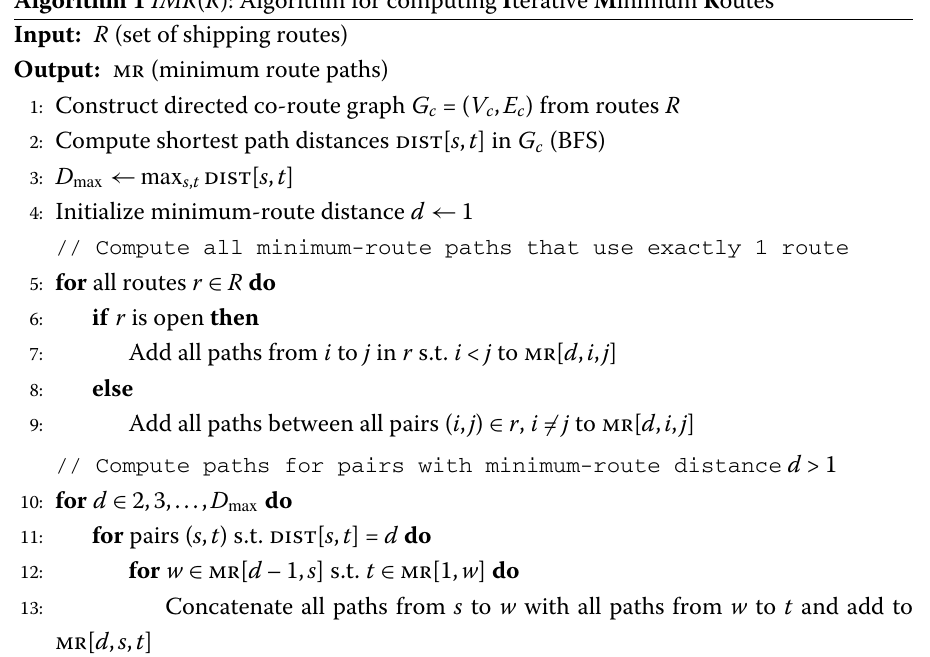
Algorithm 1 IMR ( R ): Algorithm for computing I terative M inimum R